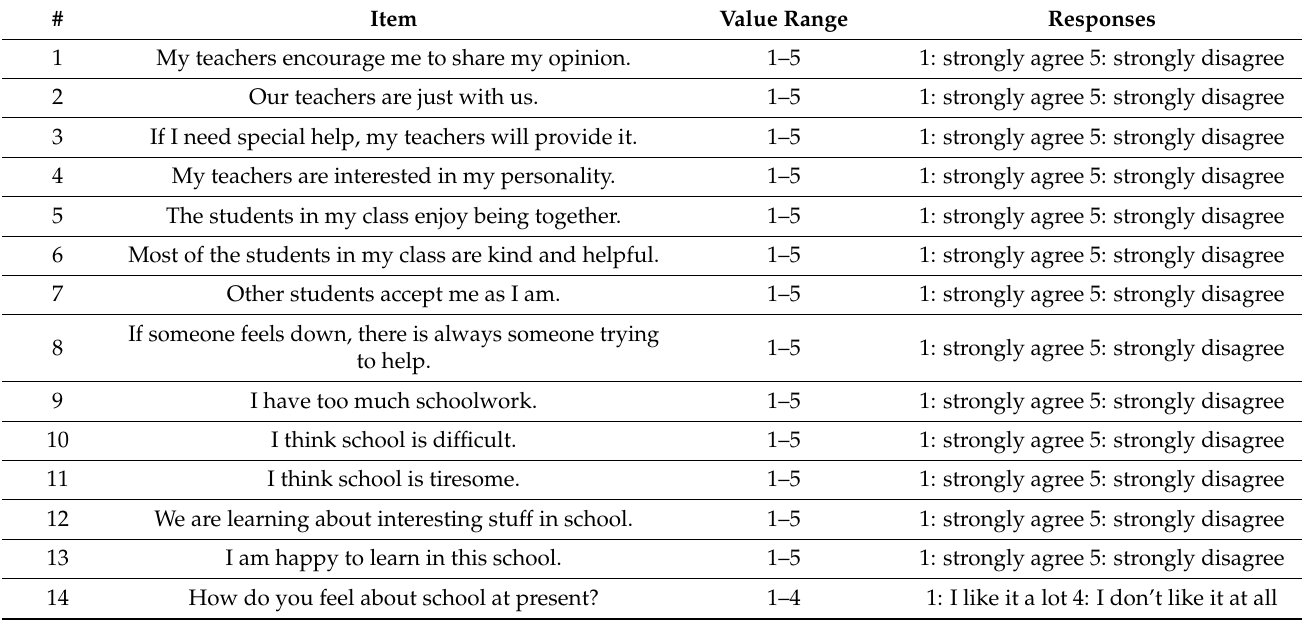
Table 1. Items related to pupils’ attitudes towards teachers, classmates, schoolwork, and